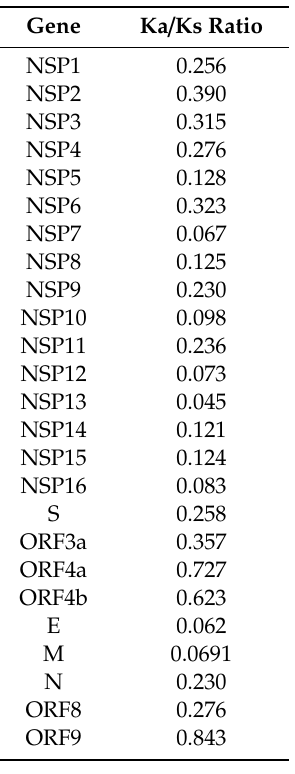
Table 4. Estimation of nonsynonymous and synonymous substitution rates in the genomes of BtCoV / Rh /